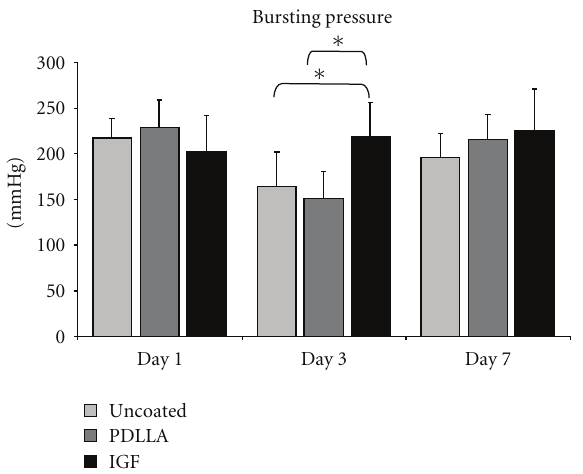
Figure 4: Statistical analyses of the bursting pressure tests showed a decrease of stability three days after surgery in the control groups (uncoated and PDLLA coated). This decrease was not seen in the IGF-I-treated specimens. At day three after surgery, a significant higher bursting pressure was measured in this group compared to the controls. 7 days after surgery no significant di ff erence was seen in between the groups. Statistical analyses were performed using ANOVA analyses and were adjusted with the Bonferroni test ( ∗ P ≤ 0 . 05).